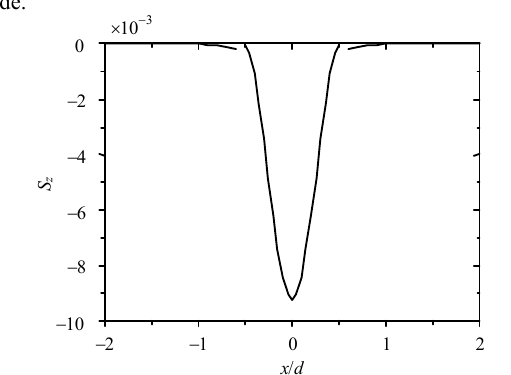
2 k d  for LCP odd fundamental 0